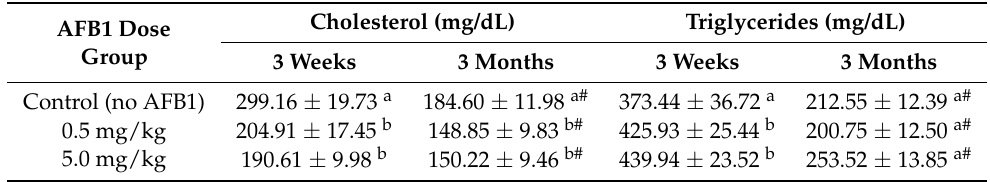
Table 2. Cholesterol and Triglyceride Concentrations in Liver at 3 Weeks and 3 Months of Age by Exposure